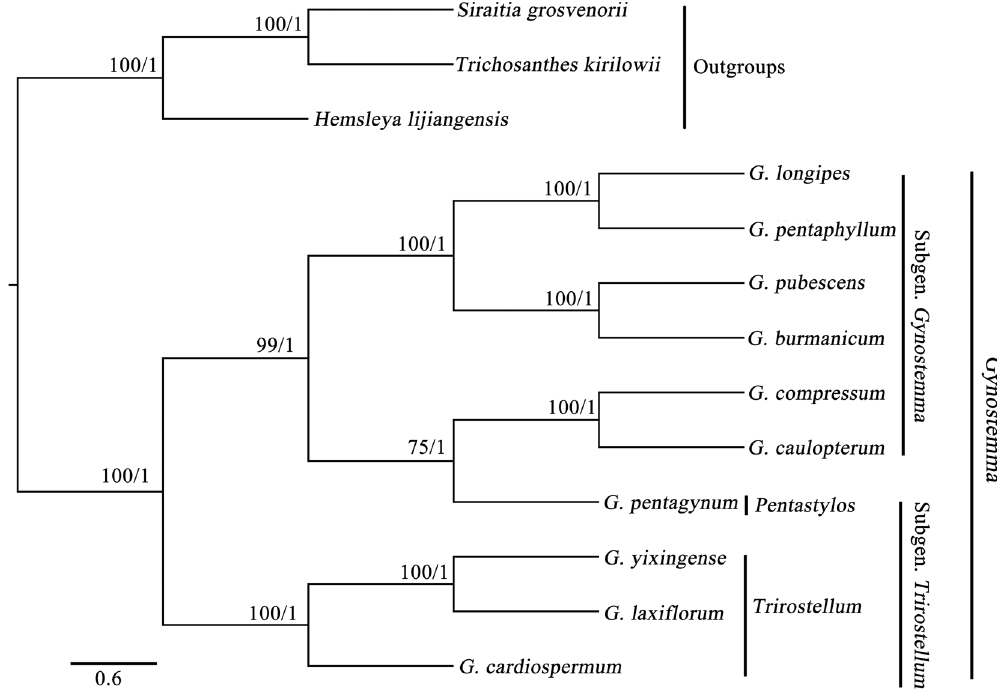
Figure 3 - The Bayesian Phylogenetic tree based on ten Gynostemma species. Numbers above the branches represent MP bootstrap (BS) and Bayesian posterior probabilities (PP)